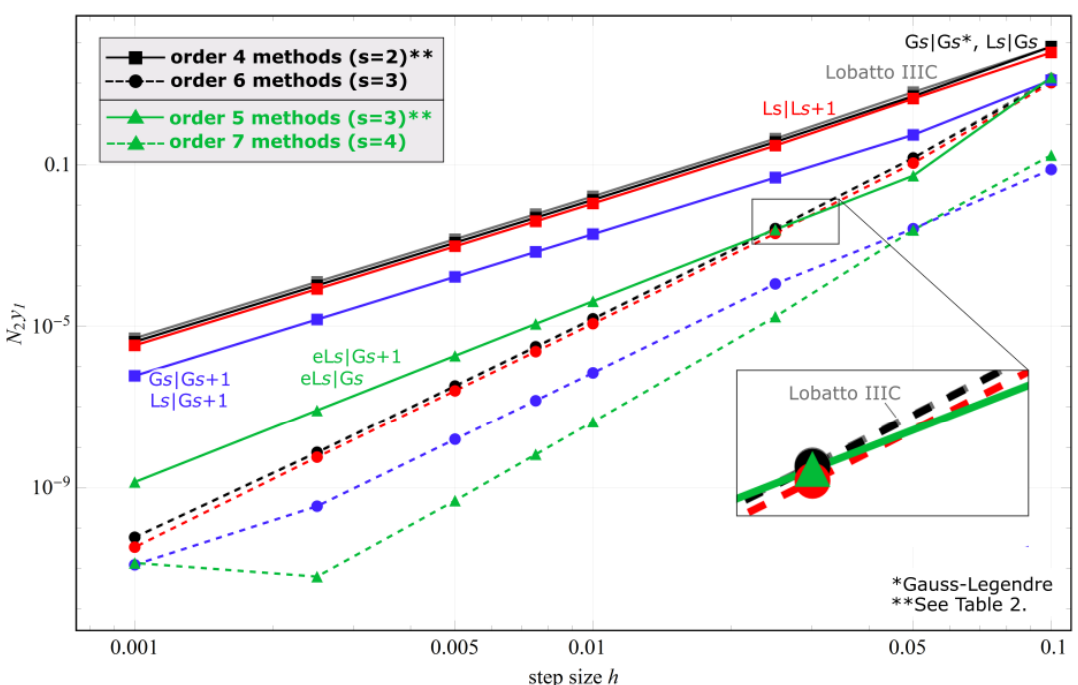
294 Figure 1. The error of different methods (as the 𝐿 2 norm) vs. the step size in Example 1 (log–log scale). The method ac- 295 Figure 1. The error of different methods (as the L 2 norm) vs. the step size in Example 1 (log–log scale). The method accuracy curacy is reported in Table 2. 296 is reported in Table